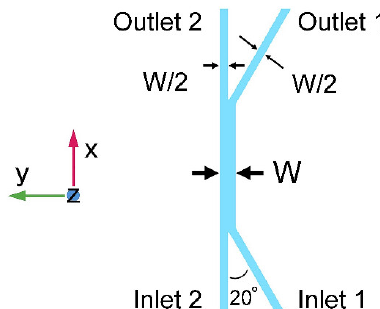
Figure 1. Schematic of the channel network for simulation and experiments (top view). The three- dimensional diagram of the network consists of two inlets, two outlets, and a diffusion channel where electrolyte diffuses between two laminar